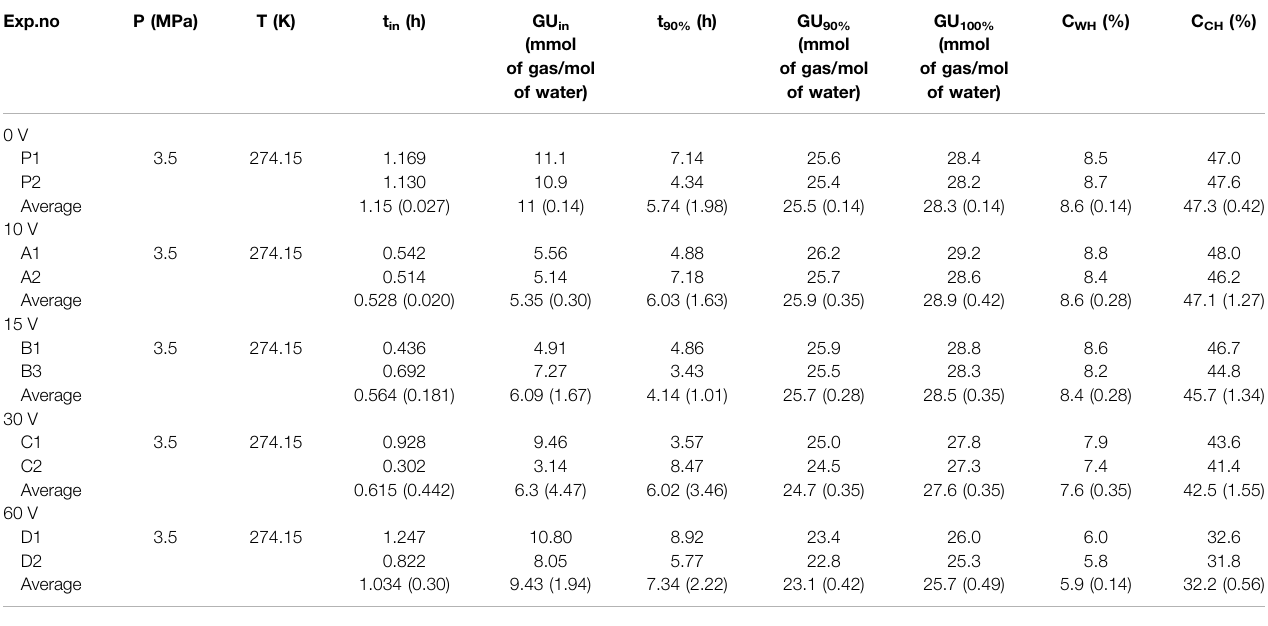
TABLE 1 | Experimental results of CO 2 hydrate formation in different conditions. Exp.no